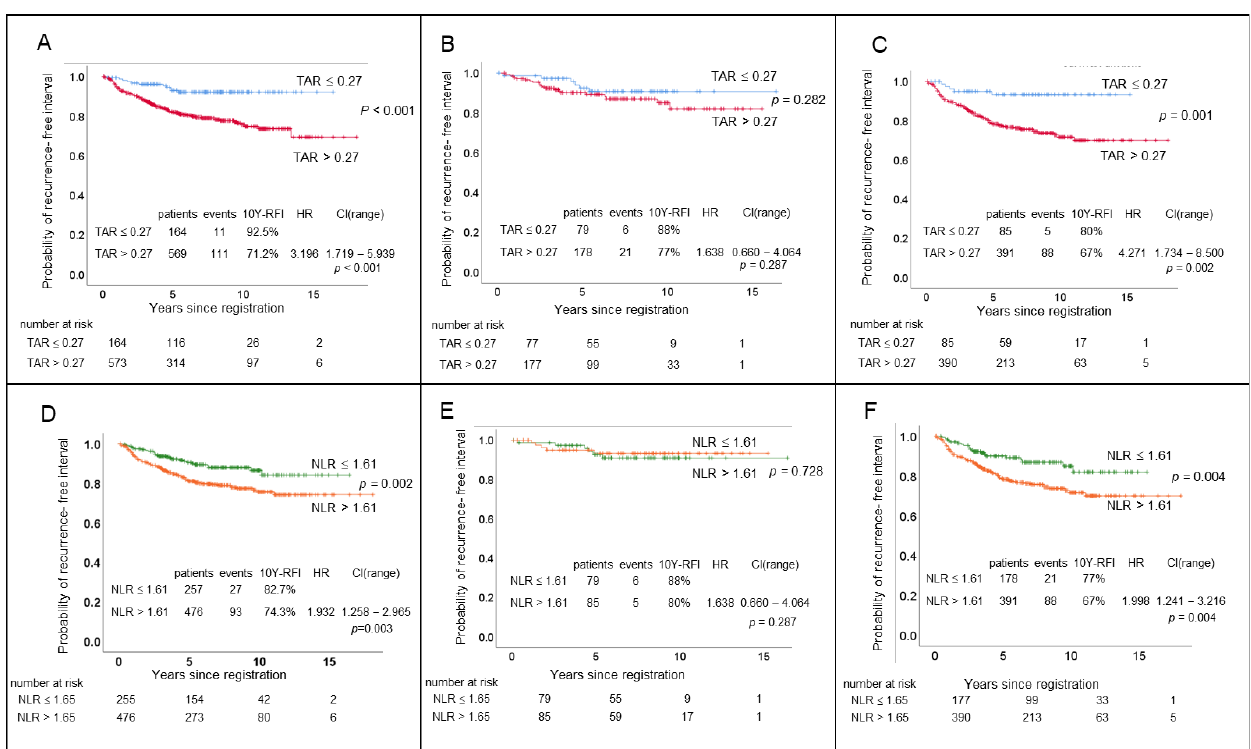
Figure 2. The recurrence-free interval (RFI) among patients with high and low tumor-to-aorta ratios (TAR) of Hounsfield units on contrast-enhanced computed tomography and serum neutrophil-to- lymphocyte ratio (NLR). Patients were dichotomized into high and low TAR groups with a cut-off value of 0.27 ( A − C ) and high and low NLR groups with a cut-off value of 1.61 ( D − F ). The RFI was defined as the time from pathological diagnosis of primary disease to invasive ipsilateral breast tumor recurrence, local/regional invasive recurrence, distant recurrence, or death from breast cancer, whichever occurred first. A Kaplan – Meier (KM) graph was generated and compared with a log-rank test to see the RFI difference. Patients with high TAR ( A ) and high NLR ( D ) showed worse RFI than their counterparts. However, this RFI disadvantage of high TAR and high NLR was found only when patients had high values of both TAR and NLR ( C , F ). Y, year; HR, hazard ratio; CI, confidence interval.